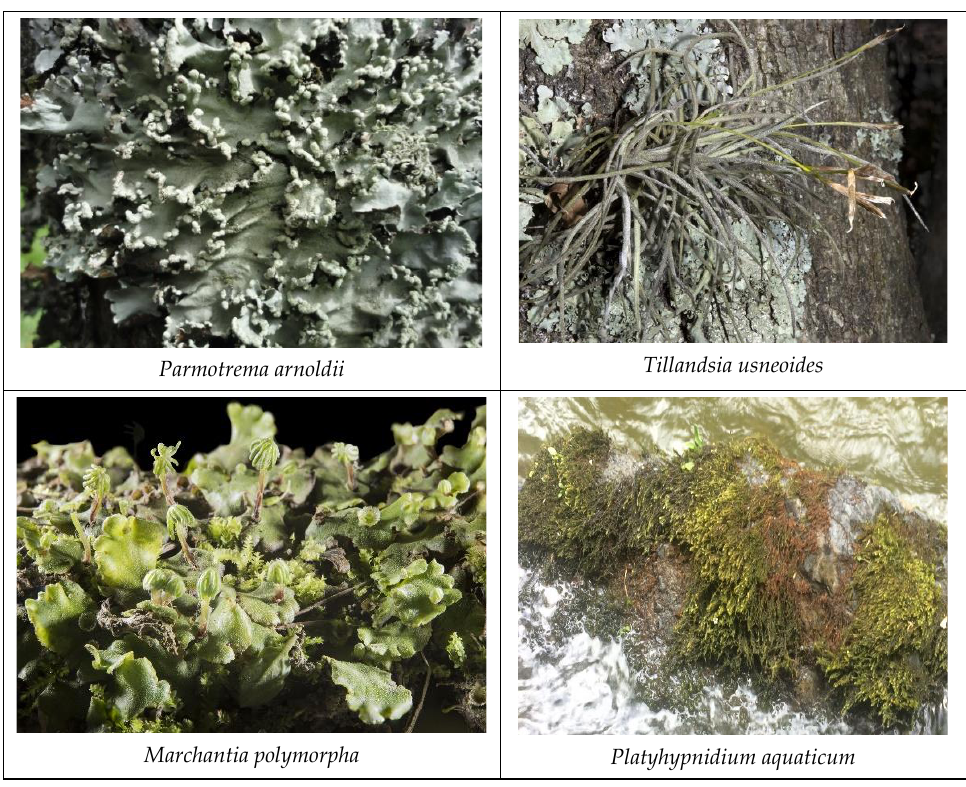
Figure 2. Bryophytes, lichens and bromeliads for evaluating air and water pollution in an Andean city.